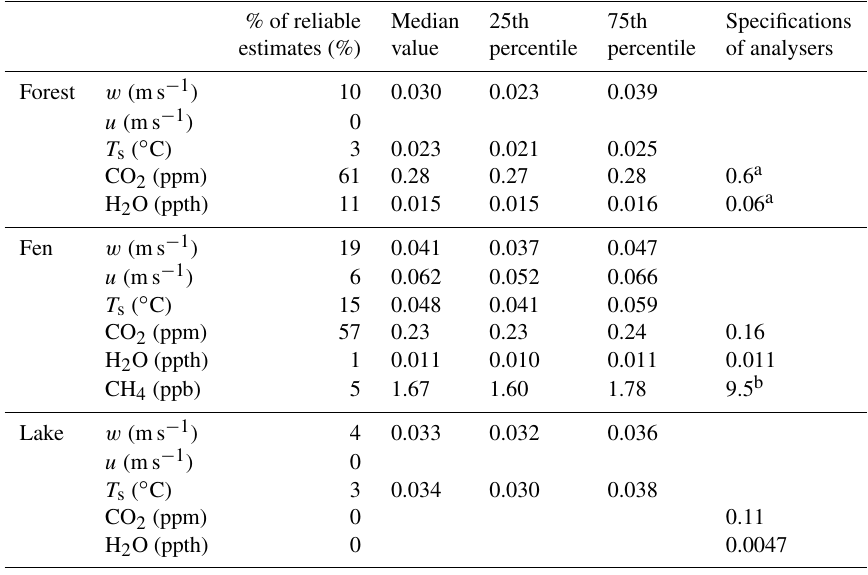
Table 3. Amount and magnitude of reliable noise estimates obtained by using Lenschow et al. (2000) method. The reported values are esti- mates of 1 SD at 10Hz sampling rate (i.e. ˆ σ n,f = 10Hz ) . Noise estimate was considered reliable if SNR<3, where SNR was calculated using the modal value of ˆ σ n,f = 10Hz obtained from the measurements. Also the performance specifications reported by instrument manufacturers are given for comparison. They are RMS values of 10Hz data if not otherwise